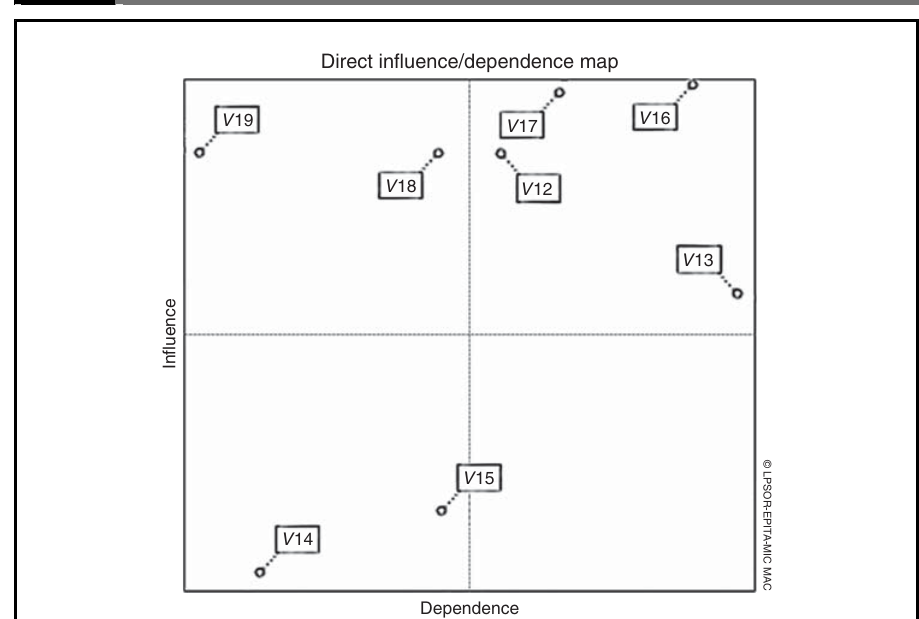
Figure 5 Direct economic negative influence and